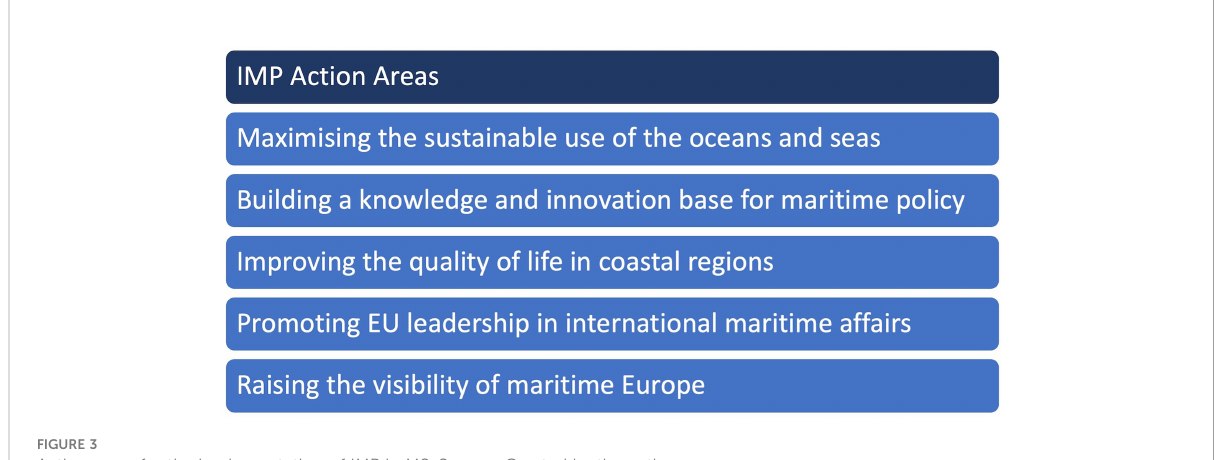
FIGURE 3 Action areas for the implementation of IMP in MS. Source: Created by the author.